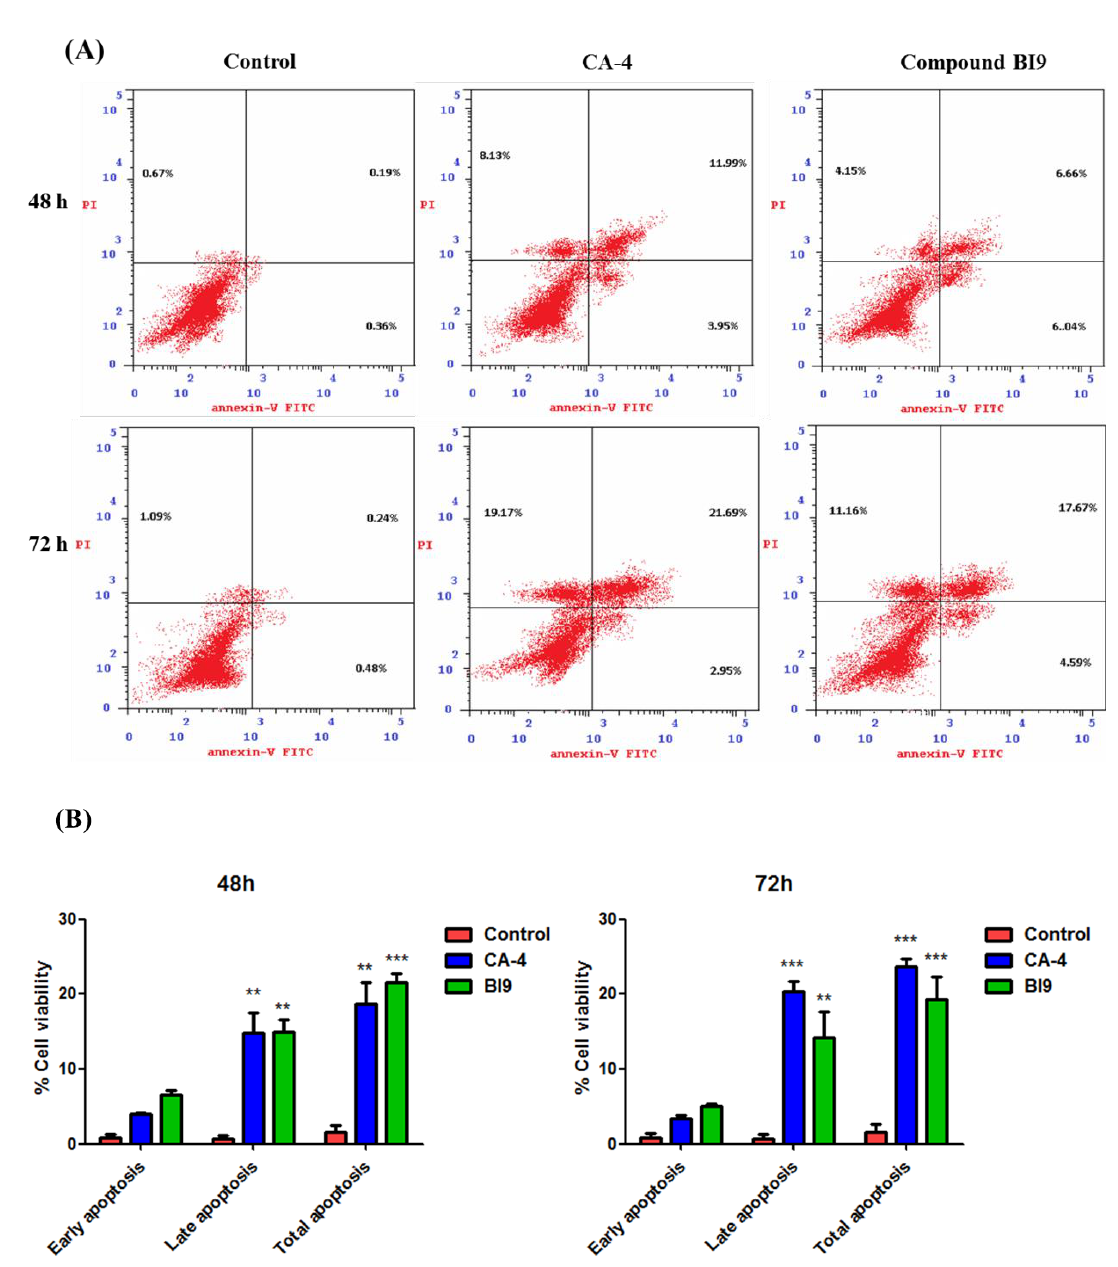
Figure 3. ( A ) Flow cytometric analysis of apoptotic cells after treatment of HL-60 cells with compounds BI9 and CA-4 after incubation for 48 or 72 h. The cells were harvested and labeled with annexin-V-FITC and PI and analyzed by flow cytometry. ( B ) Quantitative analysis of apoptosis. Dual staining for annexin-V and with PI permits discrimination between live cells (annexin-V − /PI − ), early apoptotic cells (annexin- V + /PI − ), late apoptotic cells (annexin-V + /PI + ) and necrotic cells (annexin-V − /PI + ). Data are represented as mean ± SEM of two independent experiments.